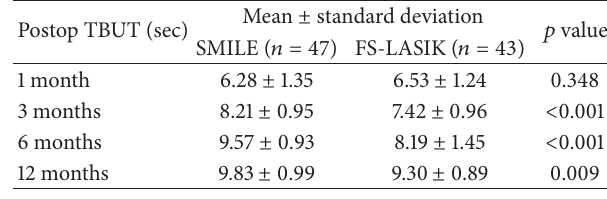
Table 3: TBUT between SMILE and FS-LASIK.